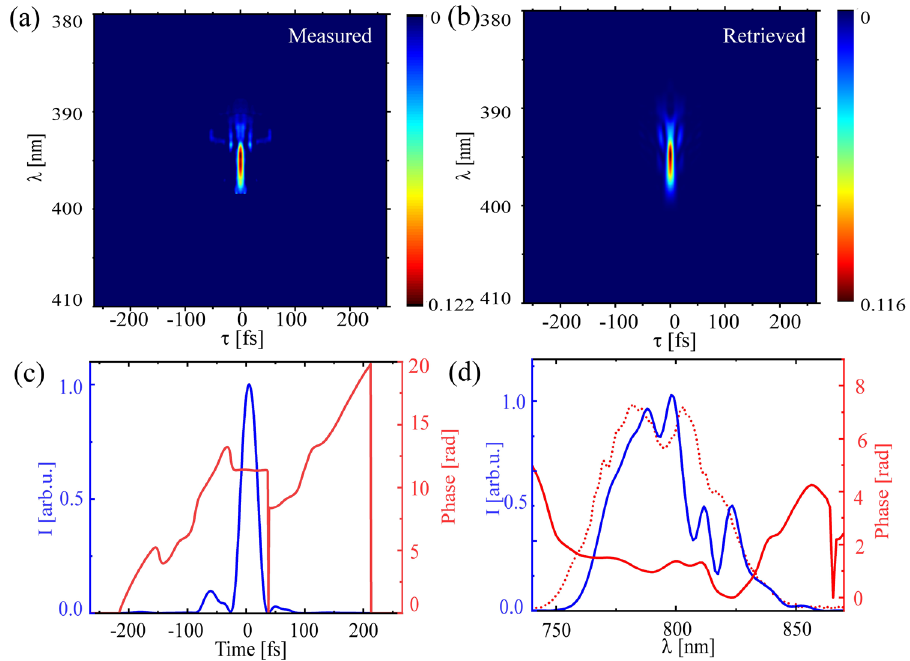
Figure 3. FROG measurement results ( a ) Measured SHG-FROG trace with all-reflective delay line. ( b ) Retrieved FROG trace. ( c ) Retrieved temporal pulse intensity (left y-axis) and phase (right y-axis). ( d ) Retrieved spectral intensity (left y-axis) and phase(right y-axis). Dotted red line shows the measured spectrum, same as in Fig. 2d, for